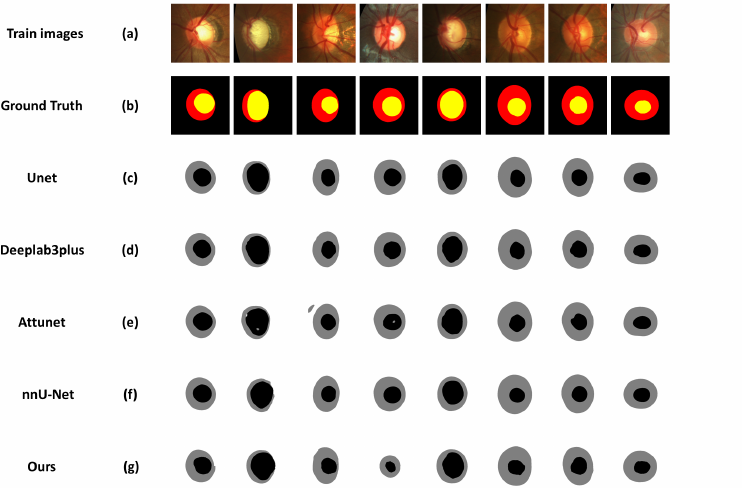
Figure 7. Visualization of OD and OC segmentation results on the REFUGE dataset. From top to bottom: ( a ) REFUGE images. ( b ) The ground truth. ( c ) The segmentation results of U-Net. ( d ) The segmentation results of Deeplabv3plus. ( e ) The segmentation results of AttU-Net. ( f ) The segmentation results of nnU-Net. ( g ) The segmentation results of our Polarformer.